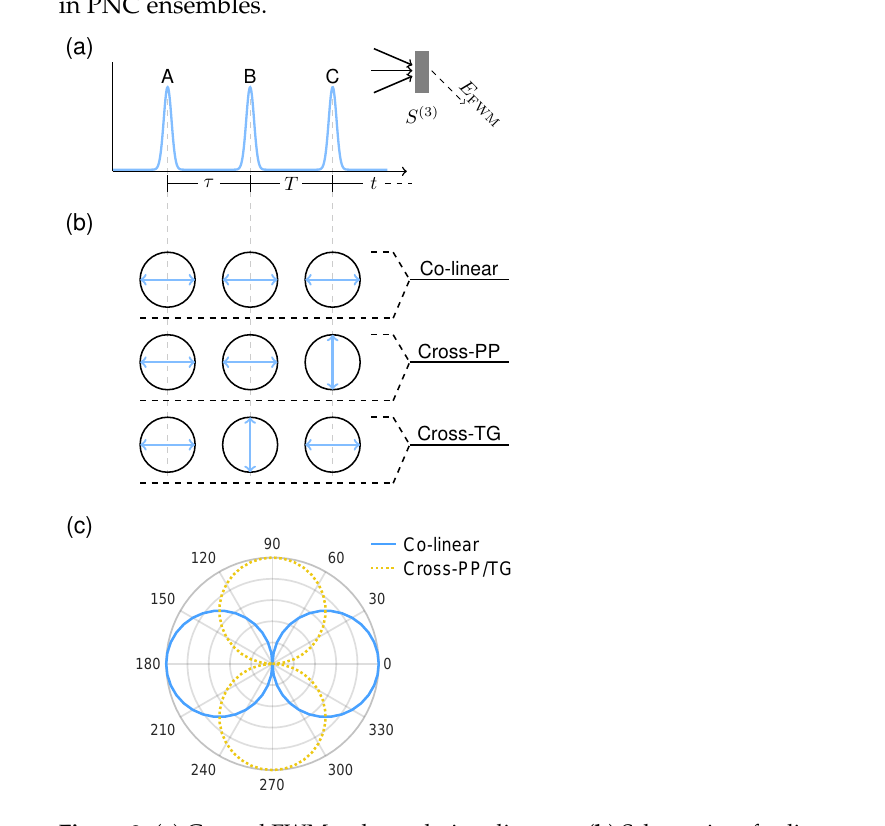
Figure 2. ( a ) General FWM pulse-ordering diagram. ( b ) Schematics of colinear, cross-linear pump- probe (cross-PP), and cross-linear transient-grating (cross-TG) polarization schemes. Indicated polarizations correspond to pulses A, B, and C from left to right respectively. ( c ) Calculated polariza- tion dependences of the rotational-averaged FWM signals for each polarization scheme, in which the linearly-polarized selection rules are preserved. Table 1. Rotational-averaging coefficients (cid:104) C (cid:105) of third-order quantum pathways beginning with excitation of | ψ x (cid:105) for each polarization scheme. Remaining coefficients may be determined by cyclic permutation of the dipole moments { µ X , µ Y , µ Z }